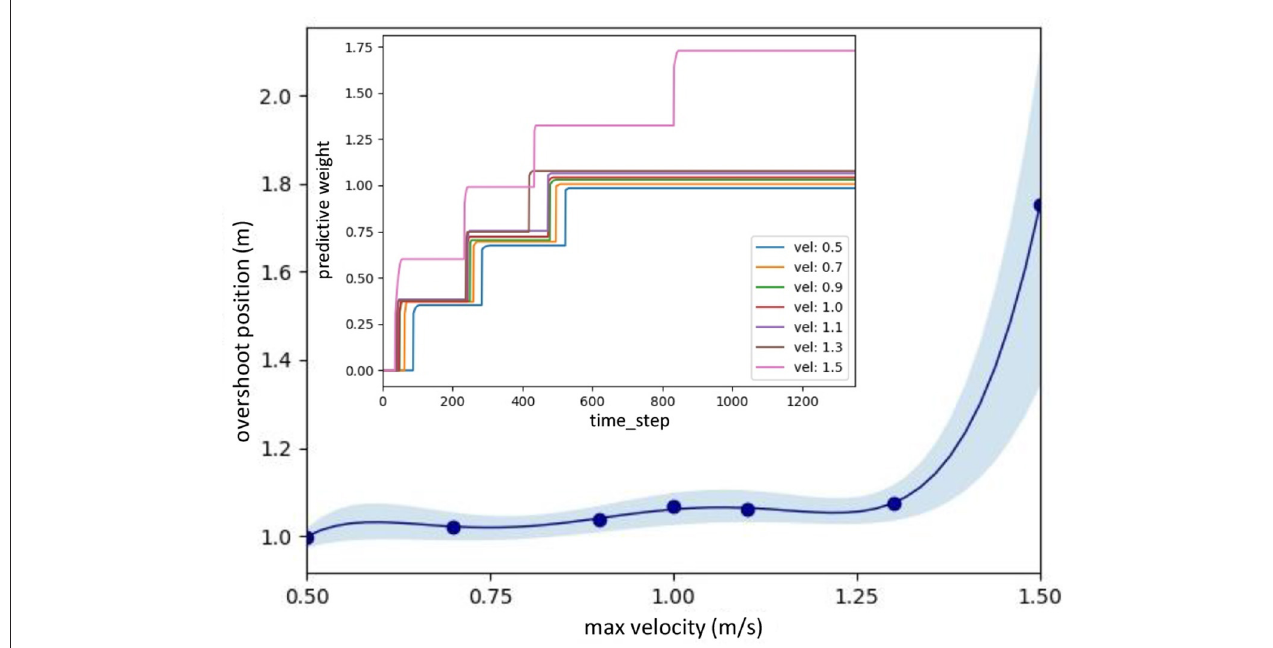
FIGURE 7 | Approximated predictive weights based on the seven learned weights at the maximum flying speeds of 0.5, 0.7, 0.9, 1.0, 1.1, 1.3, and 1.5 m/s. For the seven speeds, we repeated the learning process seven times each. The inset illustrates the learning curves of predictive weights at the maximum flying speeds. It can be seen that the learning process was fast where the weights converged after 3–4